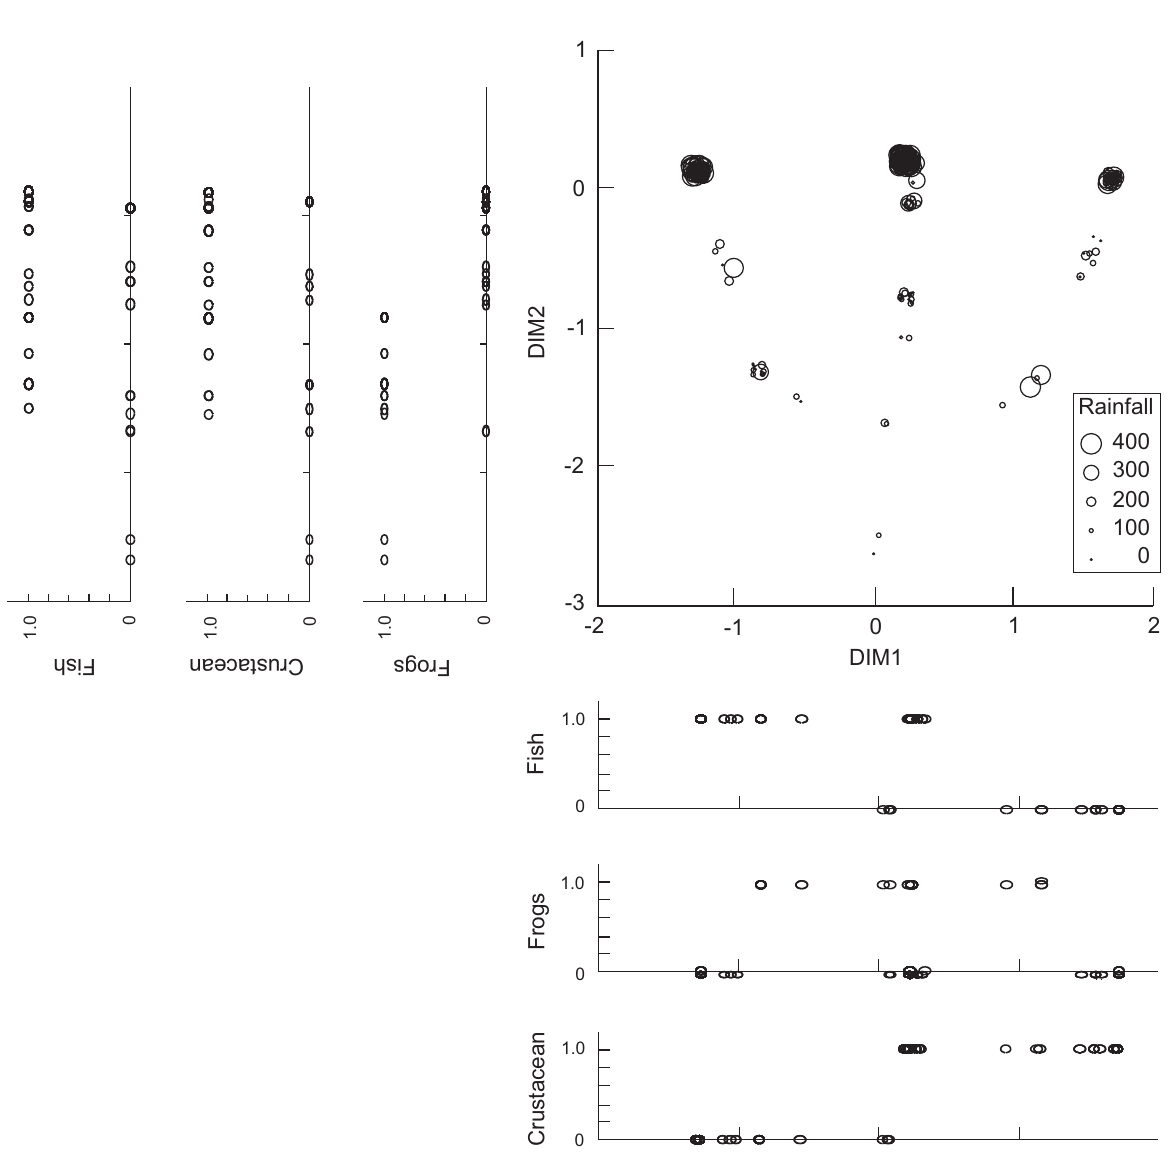
Figure 2. Neotropical otter, L. longicaudis diet differences in the Mambucaba River catchment in relation to